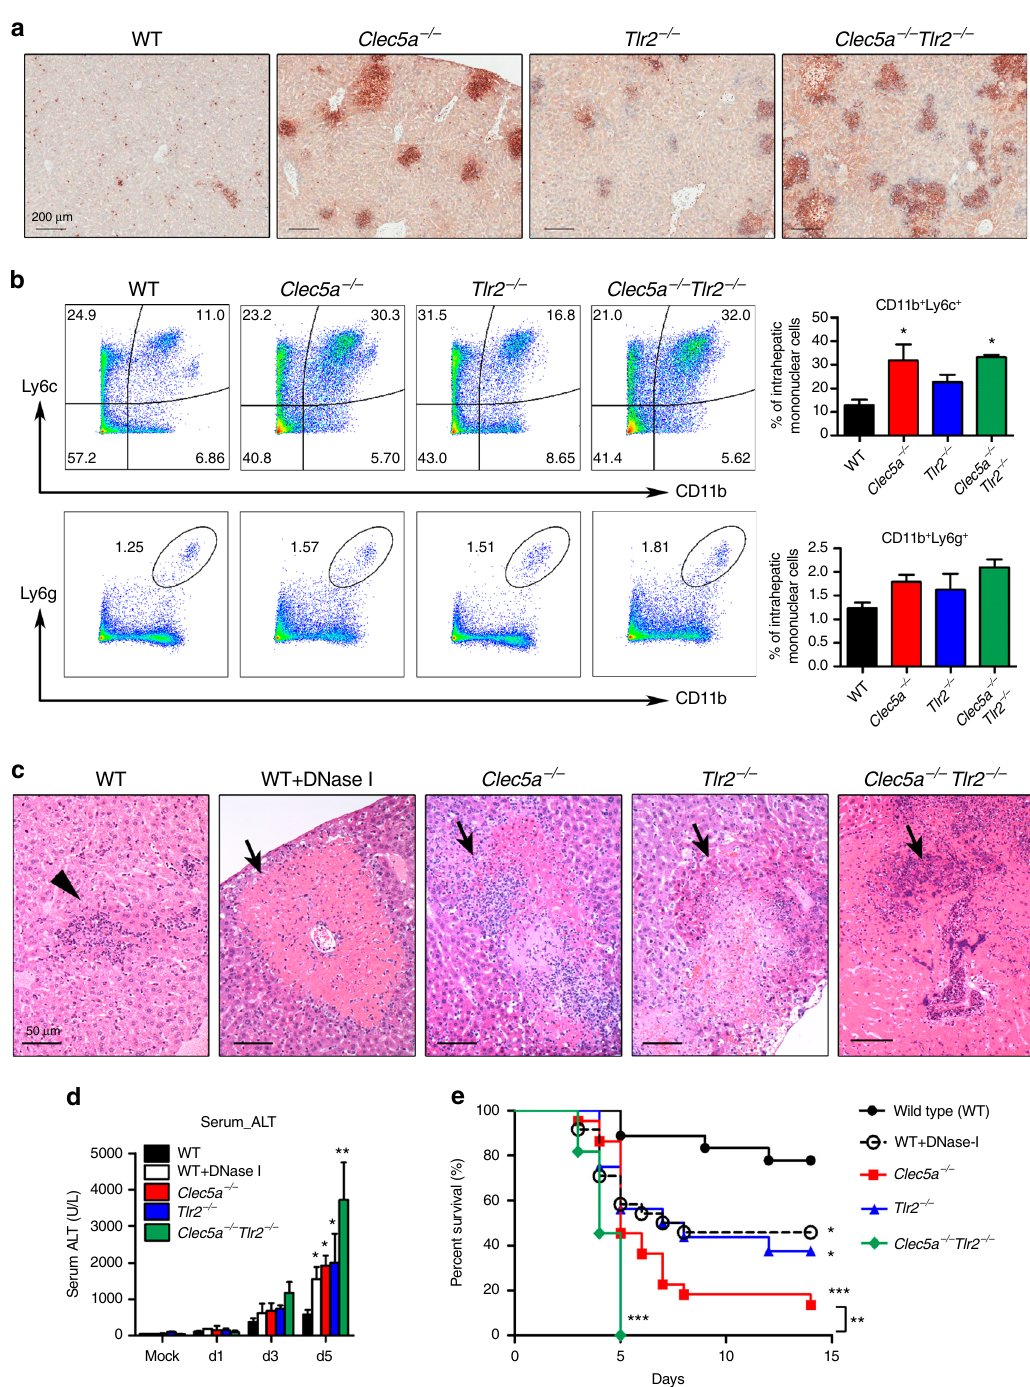
Fig. 5 CLEC5A de fi ciency results in severe liver in fl ammation and high mortality. a , b All groups of mice were intravenously challenged with 1 × 10 5 CFUs of L. monocytogenes ( 10403S). a Livers were collected and fi xed at day 5 post-infection, followed by immunohistochemical staining using anti-Ly6B.2 antibody to determine the presence of Ly6B.2 + cells. b Left : representative FACS plots of CD11b + Ly6c + monocytes and CD11b + Ly6g + neutrophils in mouse liver at day 5 post L. monocytogenes infection. Right : The data were collected from three independent experiments ( n = 9 for each group). c H&E staining of liver section. Arrowhead : abscess. Arrow : region of necrosis (5 mice per group). d Alanine aminotransferase activity in serum ( n = 20). e Survival rate was assessed daily for 15 days. The data were collected from four independent experiments, and the percentage of survived mice was displayed as Kaplan – Meier survival curves with log rank test ( n = 20 for each group). The data were collected and expressed as mean ± s.e.m. from four independent experiments ( n = 20). One-way ANOVA was performed. * P < 0.05, ** P < 0.01, ***, P < 0.001 for WT versus knockout mice, WT versus WT/DNase-I mice or indicated two